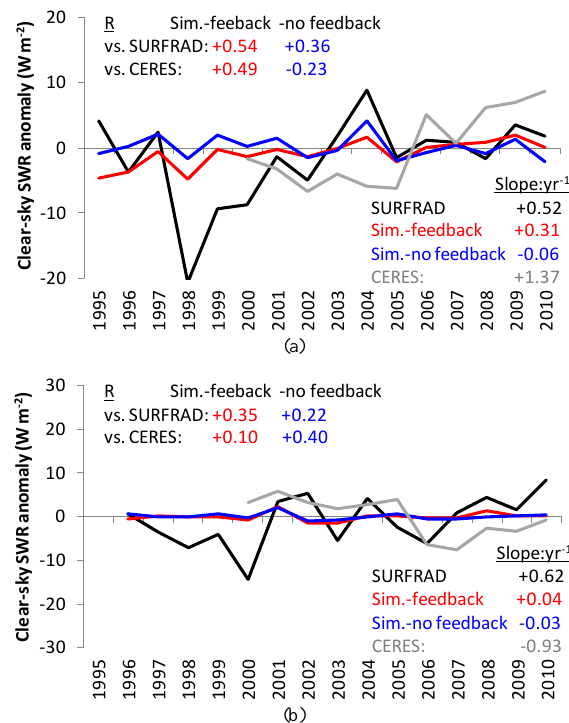
Figure 8. Comparison of SURFRAD/Ceres observed and WRF- CMAQ clear-sky SWR at the surface: (a) the eastern US and (b) the western US (site-averaged, anomaly in the average of 1995–2010).